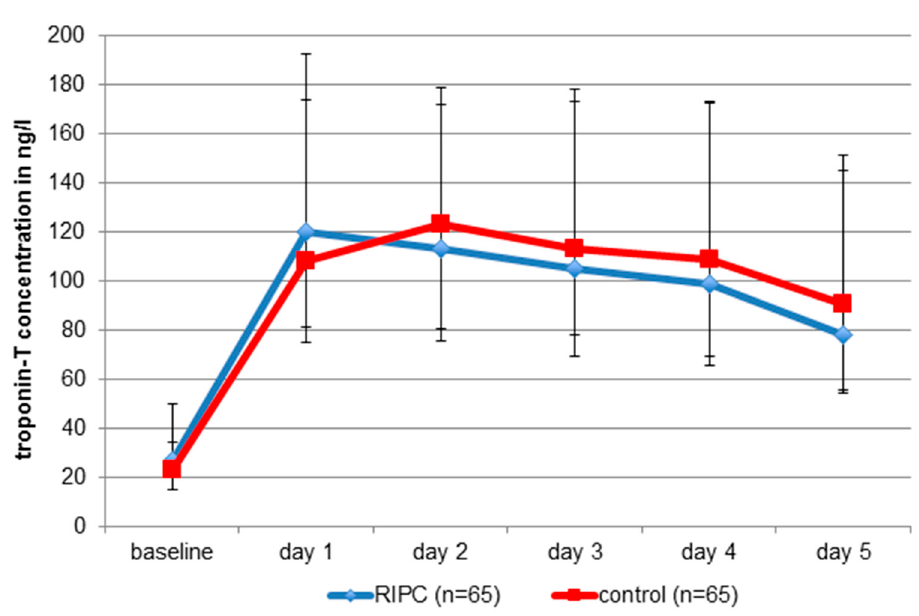
Figure 4. Absolute hsTnT concentrations of the RIPC group and matched control group patients. No statistically significant differences between groups with respect to maxima and area under the curves. Values are median (IQR). RIPC = remote ischemic preconditioning.